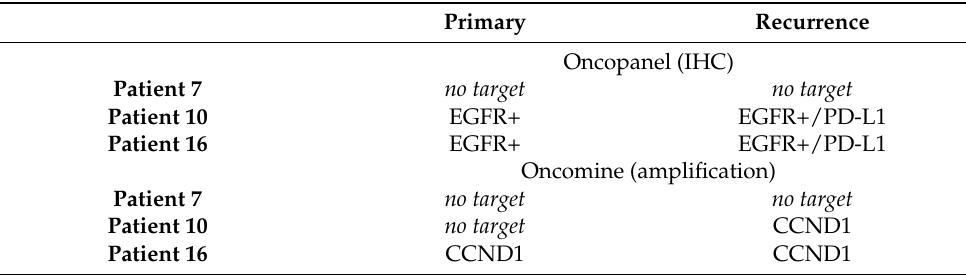
Table 3. Tabular comparison of the primary and recurrent tumor tissue for both panels. Patient IDs are displayed as defined in Table